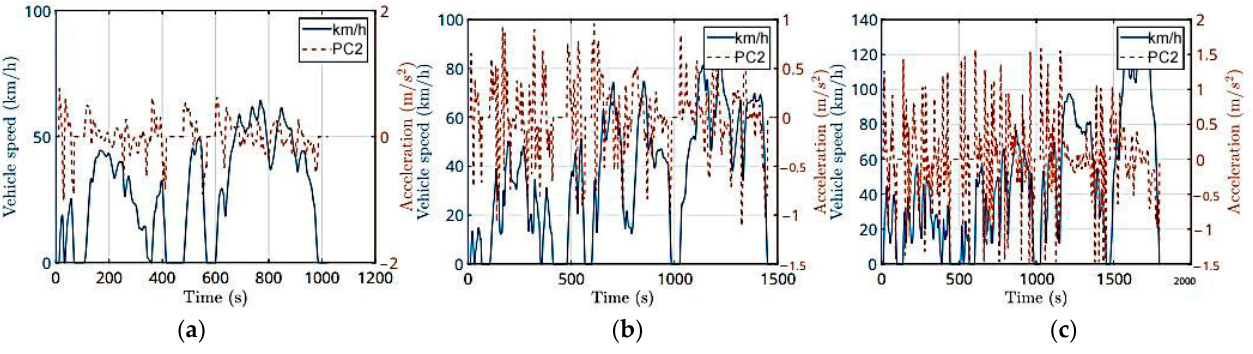
Figure 25. WLTP ride cycles for verification. ( a ) Class 1: Specific power in Watt/Mass without load in kg ≤ 22. ( b ) Class 2: Specific power in Watt/Mass without load in kg > 22 but ≤ 34. ( c ) Class 3: Specific power in Watt/Mass without load in kg > 34.